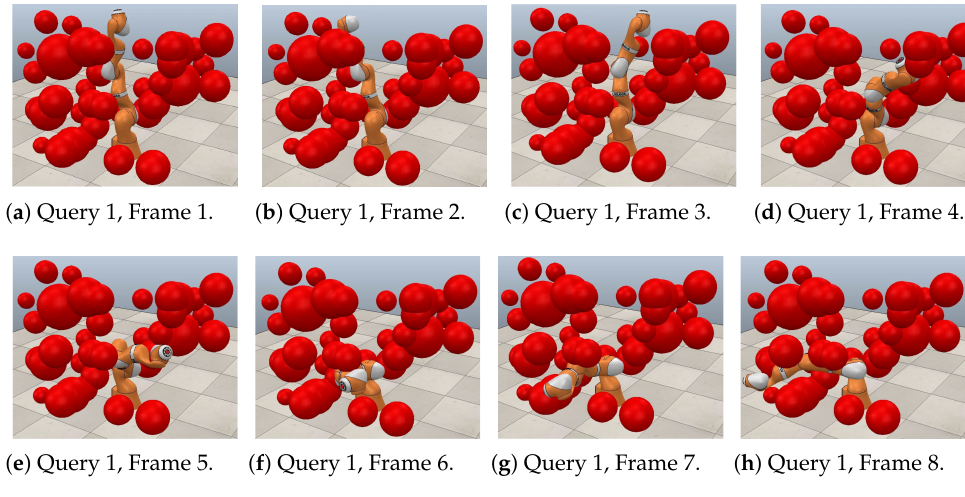
Figure 21. Collision-free path for a KUKA manipulator. Query 1, A = ( 0 ◦ , − 15 ◦ ,0 ◦ , − 30 ◦ , − 15 ◦ , − 30 ◦ ) and B = ( − 135 ◦ ,75 ◦ ,15 ◦ , − 30 ◦ ,45 ◦ , − 30 ◦ ) .